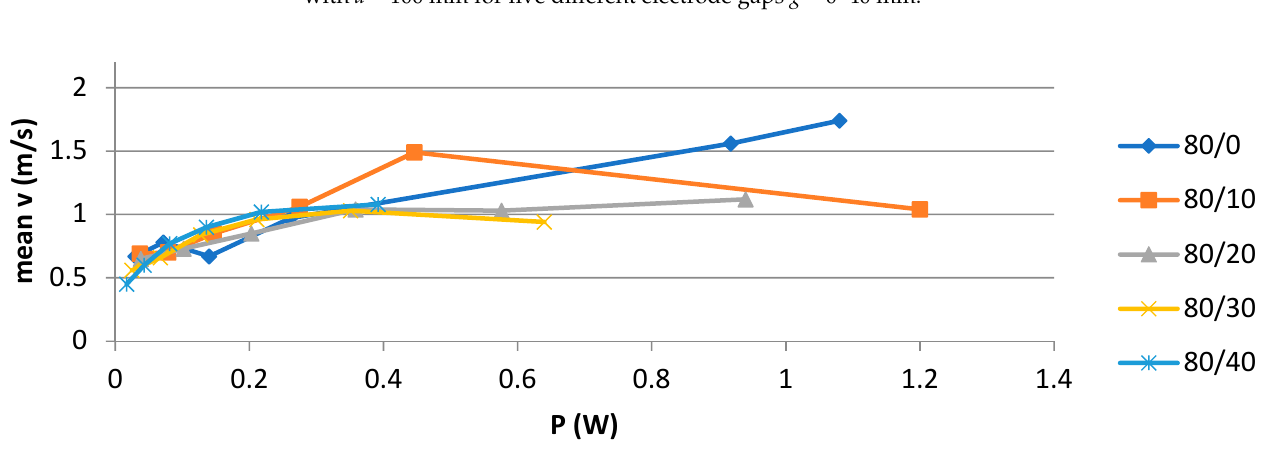
Figure 5. Measured mean velocity in the relation to the power consumption on the airflow generator with a = 80 mm for five different electrode gaps g = 0–40 mm.